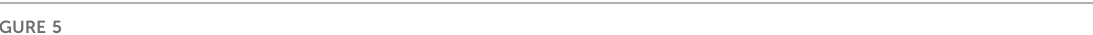
currents in four conditions: control (Figure 5A1), control plus CF (Figure 5B1, CF: sine waveform), white noise (Figure 5C1), and white noise plus CF (Figure 5D1) in the models. The F-I curves with WN were established with CF introduced to NaP (Figure 5E, green curves), CaL (Figure 5F, green curves), NaT (Figure 5G, green curves), and K(DR) (Figure 5H, green curves), respectively. To facilitate comparisons, we added several other F-I curves to the fi gures, which were obtained from the rat experiments (red curves), a control model (black curves), a model with CF (orange curves), and a model with white noise (blue curves). The simulation results indicated that with channel fl icker, the F-I curves more closely approximated those obtained from the rat experiments with WN. Among the four channels, modulating the CaL and NaP produced the closest approximation to the experimental F-I curves, followed by NaT and K(DR) in terms of F-I slopes and intercepts. The difference between experimental and modeling F-I curves included the slope of − 0.31 Hz/nA and intercept of 0.03 nA for NaP, 0.7 Hz/nA and 0.09 nA for CaL, 0.5 Hz/nA and − 0.08 nA for NaT, and − 0.02 Hz/nA and 0.17 nA for K(DR), respectively. We found that adding the channel fl icker terms substantially improved the models ’ capacity to reproduce the experimental F-I curves obtained with white